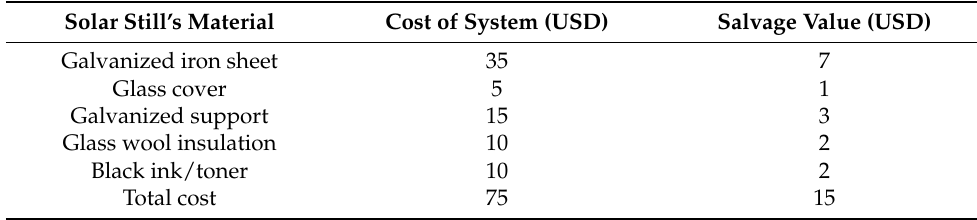
Table 4. Cost of fabricated of single-slope solar still using absorber materials.